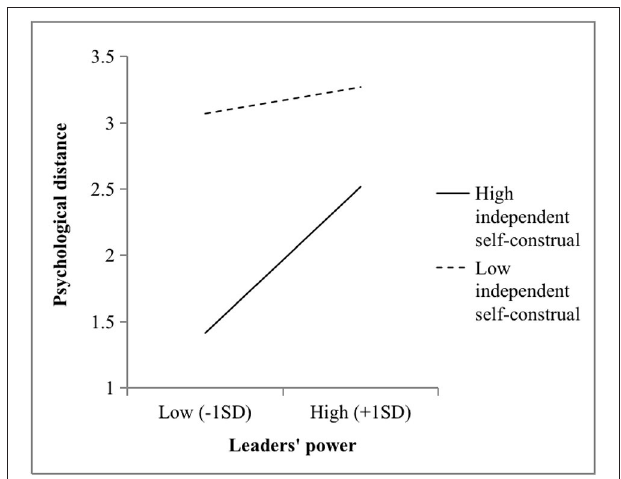
FIGURE 2 | Two-way interaction effect between the power and independent self-construals of the leaders on psychological distance in Study 1.